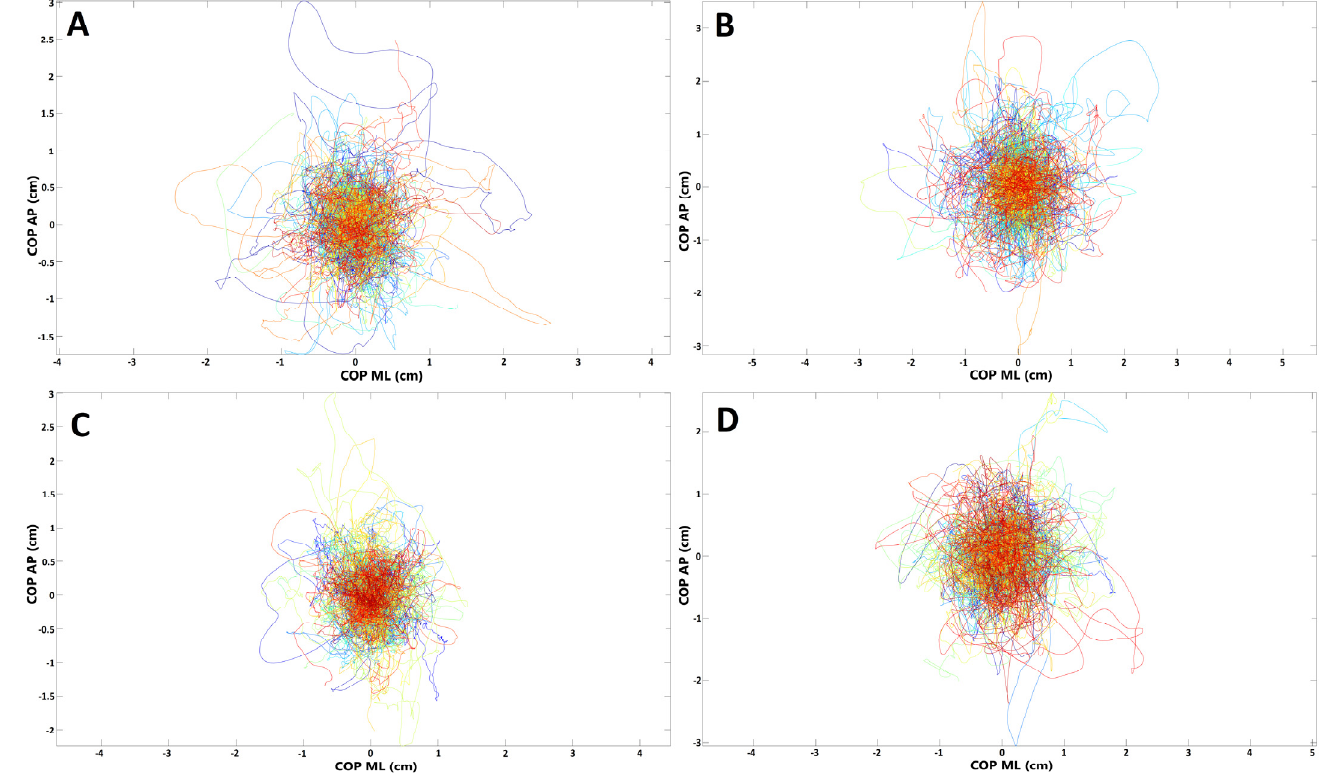
Figure 1. Presentation of COP (center of pressure) migrations in ( A , B ) subjects who recovered from COVID–19; ( C , D ) healthy controls (each line represents single participant; AP, anterior–posterior (frontal) plane; ML, medial–lateral (sagittal) plane). ( A , C ) Trials with eyes open; ( B , D ) trials with eyes closed.